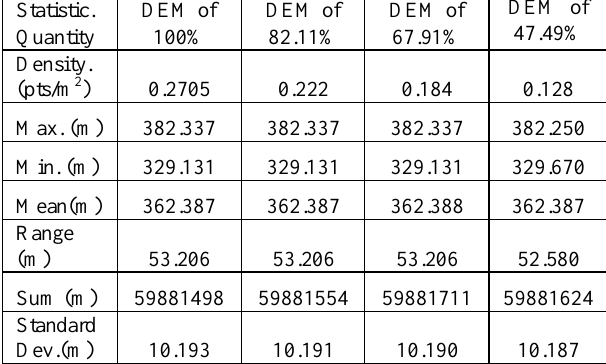
Table 1a: The statistical analysis results of the DEMs created from reduced point cloud LiDAR data.